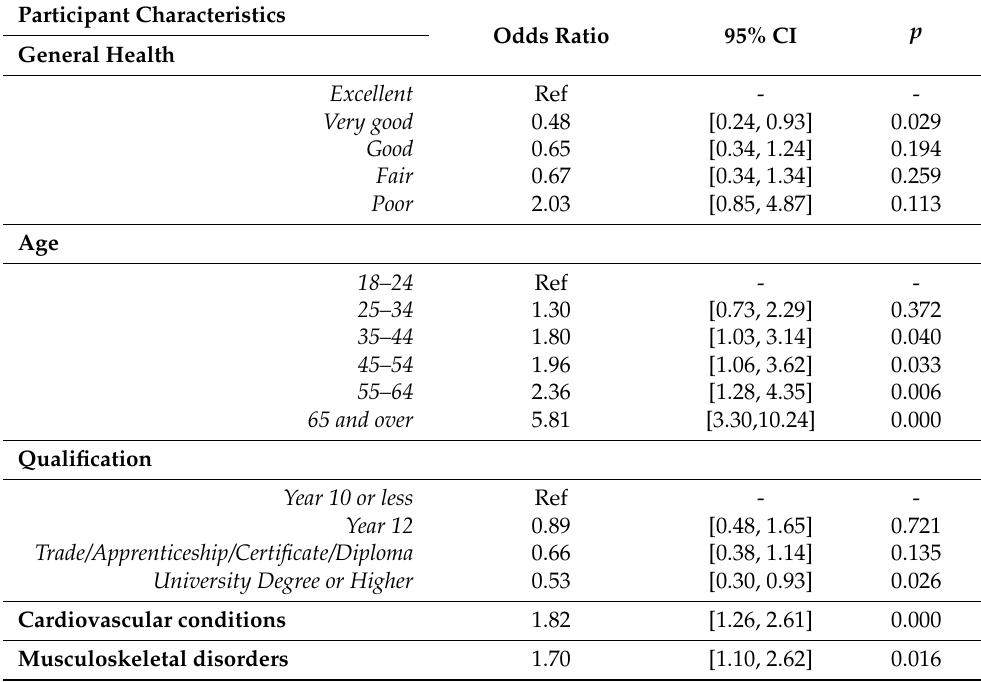
Table 5. Participant characteristics predicting same-day use of oral CM products with prescription and/or over-the-counter